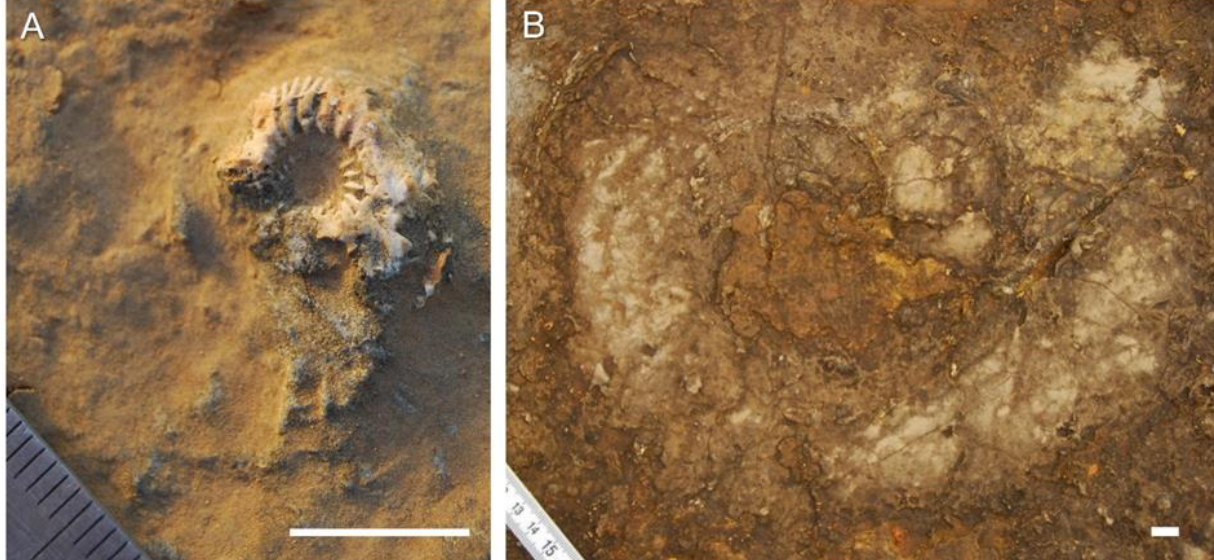
Figure 6. Selected ammonite specimens from the Cabeço da Ladeira site (photos from RP): ( A ) Stephanoceras mutabile (Quenstedt, 1886), inner whorls; ( B ) Litoceratidae gen. et sp. indet. Scale bar is 1 cm.